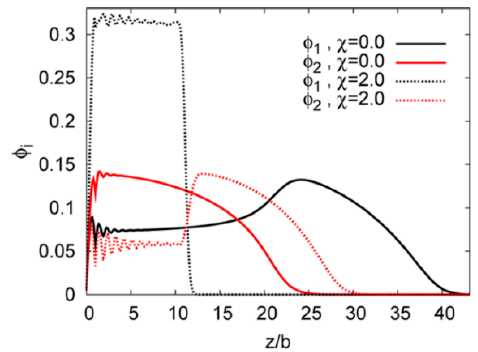
Figure 7. Composition profiles as obtained by 1D self-consistent field theory (SCFT) calculation on an asymmetric mixed polymer brush, with repeat units of N A = 64 (black) and N B = 44 (red). χ = 0 (solid lines) indicates non-selective solvent and χ = 2 (dashed lines) indicates selective solvent favoring polymer B. (Reproduced with permission from Reference [167], Copyright 2015, American Chemical So- ciety).